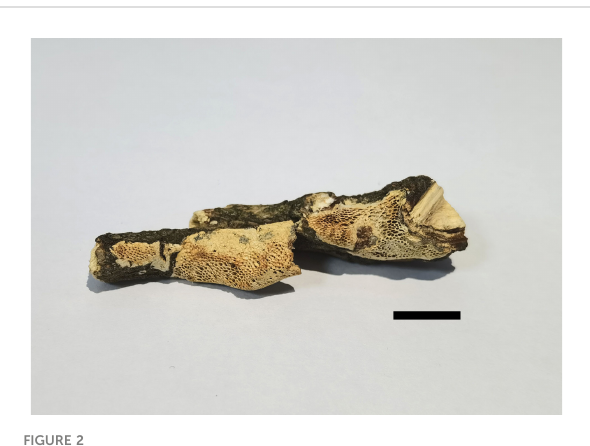
FIGURE 2 Basidiomata of Haploporus ecuadorensis (Holotype, JV1906/C10-J). Scale bar = 1.0